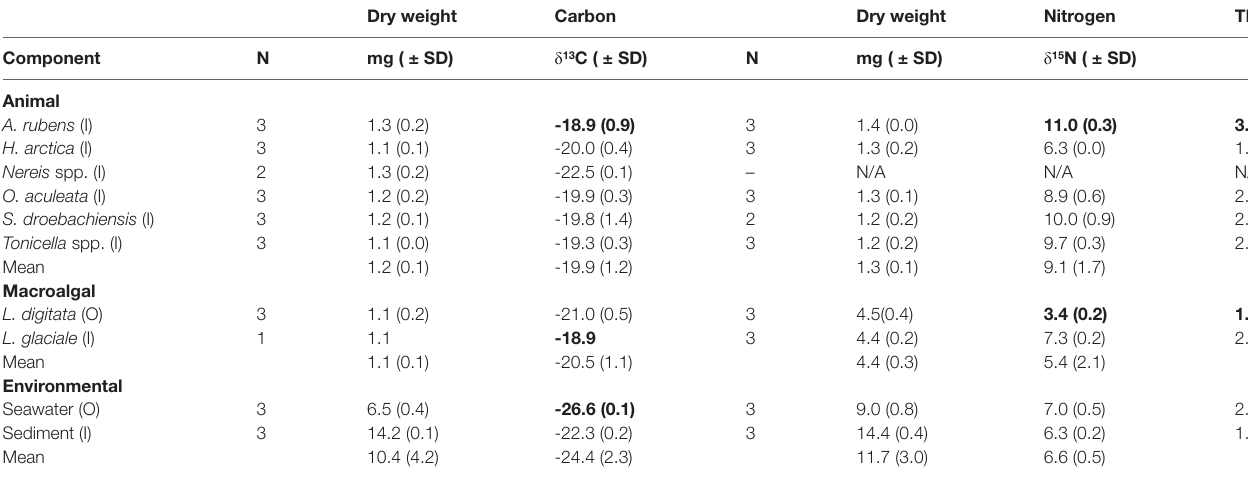
TABLE 4 | Sample size (N), bulk stable isotope ratio ( δ 13 C and δ 15 N; ‰), and relative trophic position (TP) in the six animal species, two macroalgal species, and two environmental components (see Table 1 for species list) sampled inside (I) or outside (O) of the South site (see Figure 1A